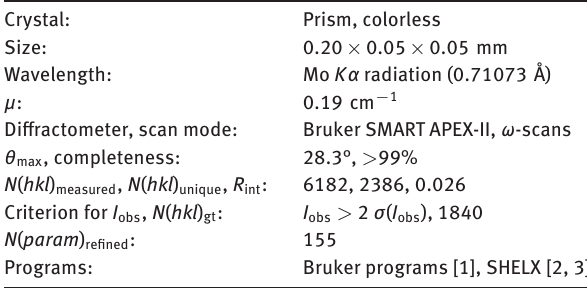
Table 1: Data collection and handling.